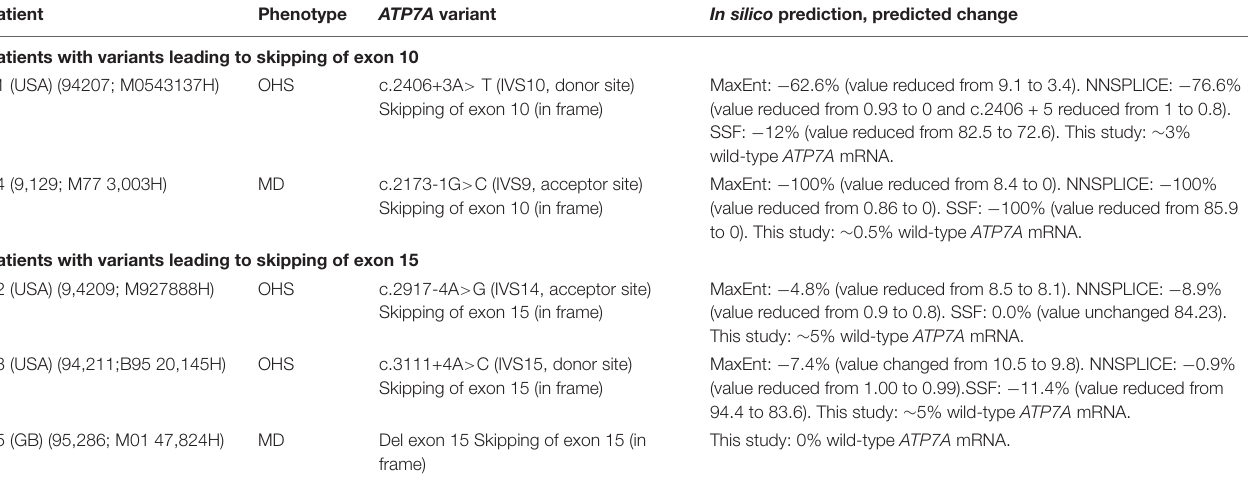
TABLE 2 | ATP7A variants investigated in this